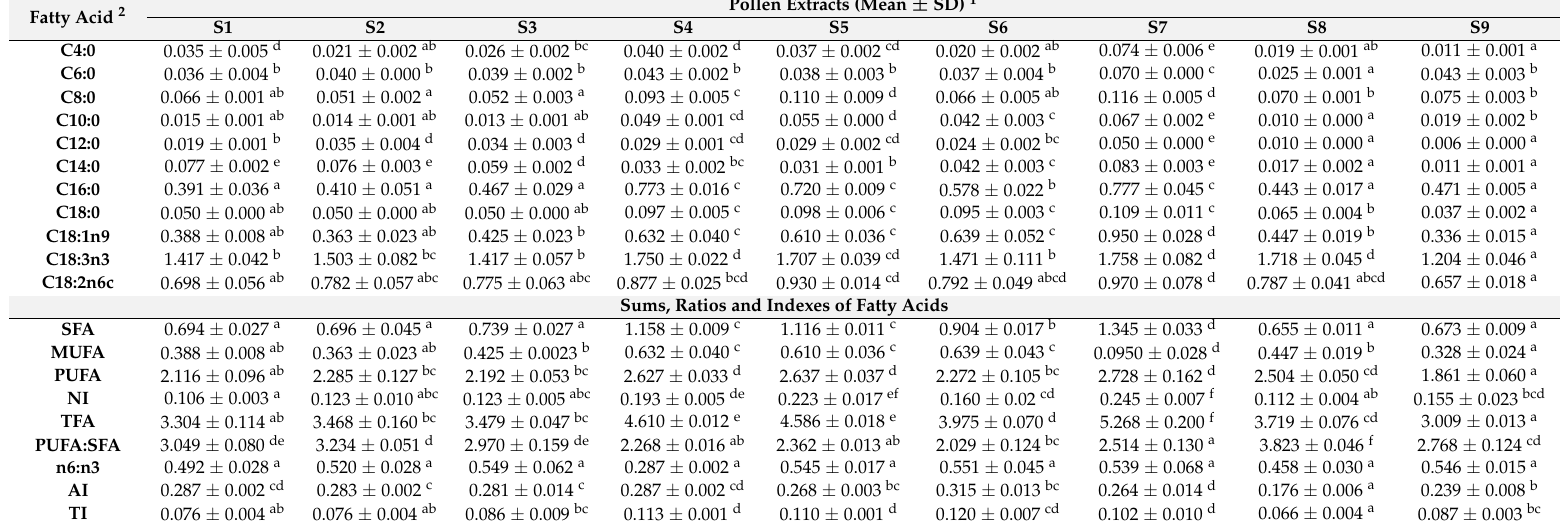
Table 1. Fatty acid composition in pollen extracts (g/100 g of bee